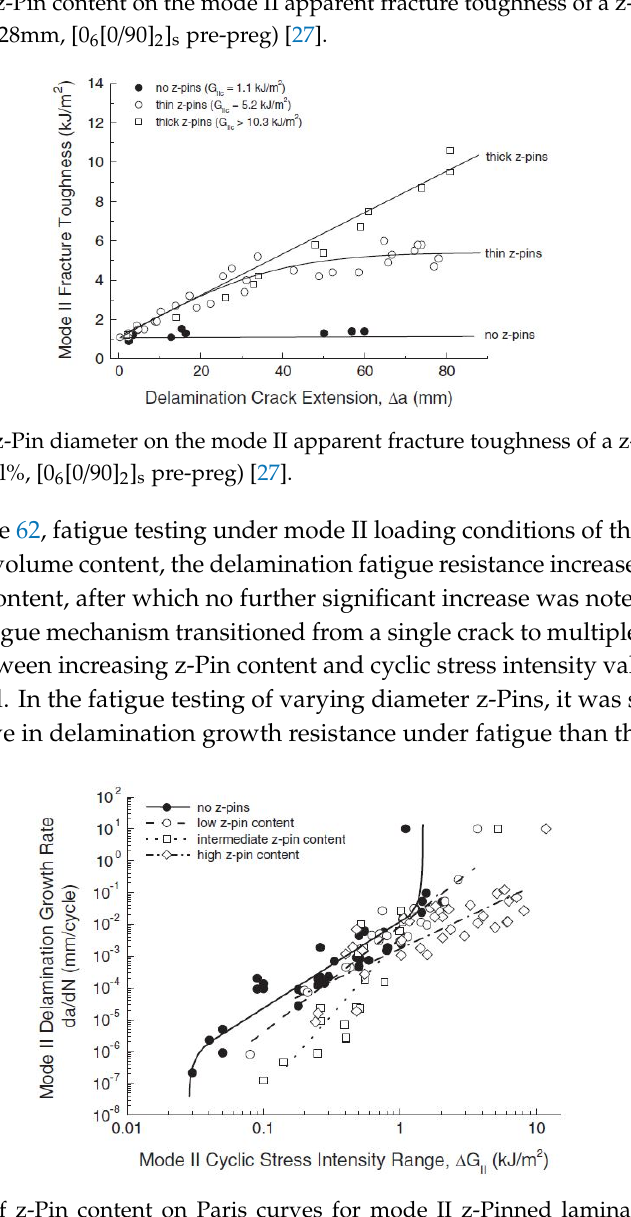
Figure 62. E ff ect of z-Pin content on Paris curves for mode II z-Pinned laminate (CFRP z-Pins, d = 0.28 mm, [0 6 [0 / 90] 2 ] s pre-preg)